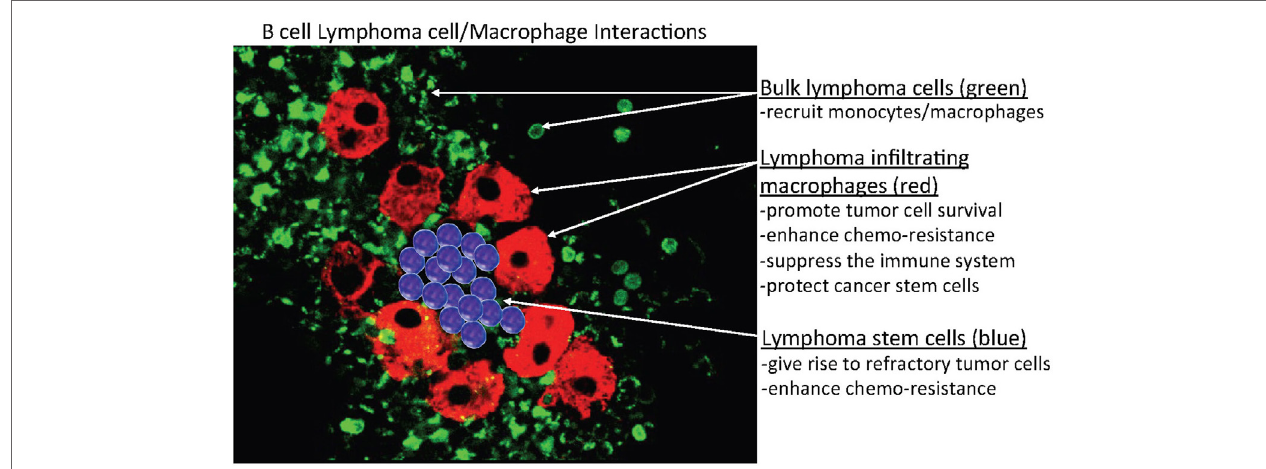
FigURe 2 | Hypothetical model of B-cell/MP interactions in B-cell lymphomas. This model predicts that indolent and retransformed or non-transformed lymphoma cells do not initially exhibit autonomous or spontaneous-independent neoplastic cell growth but instead must undergo interactions with indigenous non-neoplastic cells, specifically, monocytes or macrophages (MP)-derived tumor-associated MPs (TAMs) that bind, stimulate, and activate targeted lymphoma cells, to adopt aggressive autonomous phenotypes. The postulated mechanism for this relationship is that a high monocyte count is a surrogate biomarker for the tumor microenvironment, reflecting the functions of immunosuppressive peripheral blood monocytes recruited by lymphoma cells to differentiate monocytes into polarized MPs (M2) that can in turn activate the tumor cells. In addition, the aggregated TAMs (red) can protect tumor cells and, potentially, cancer stem cells (blue) within their clusters from chemotherapy, enabling the tumor cells to survive (residual disease) and re-establish (relapse) at a later